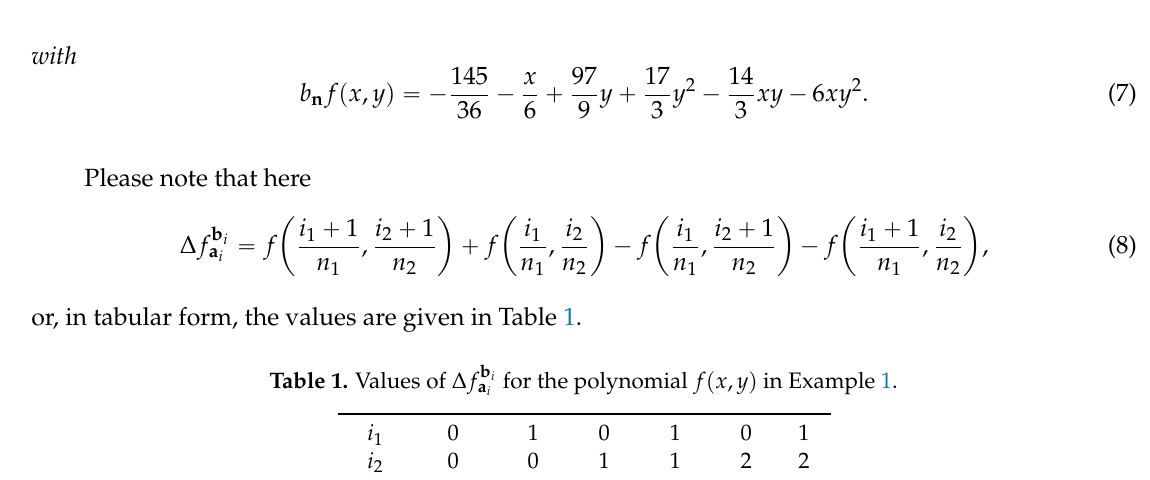
Table 1. Values of ∆ f b i a